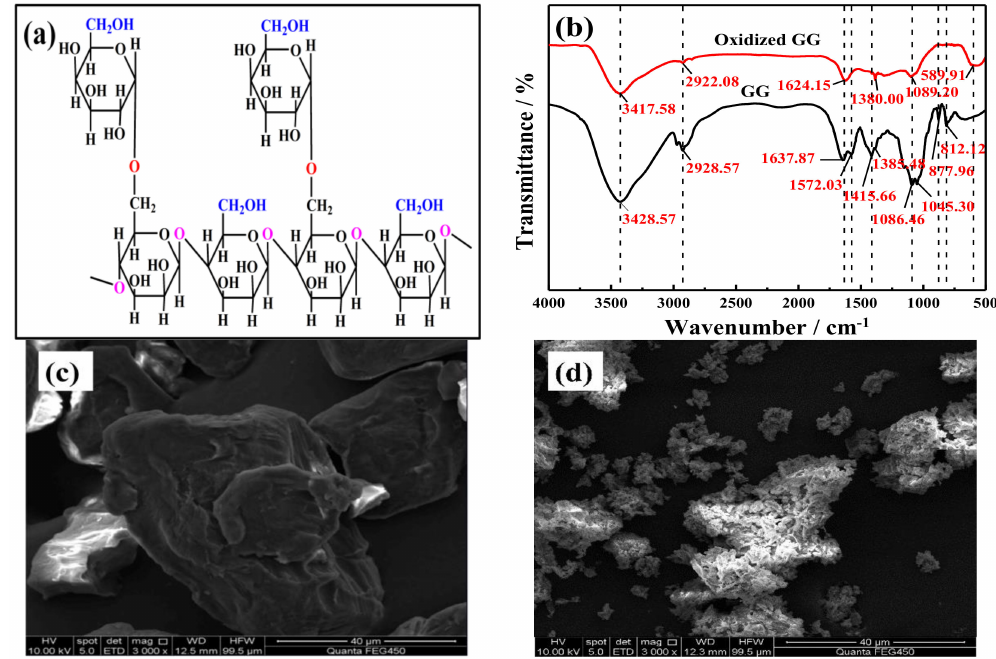
Figure 5. Characterization GG before and after oxidation with the ( a ) GG chemical structure, ( b ) FT-IR spectra ( c , d ), and SEM images of GG before and after